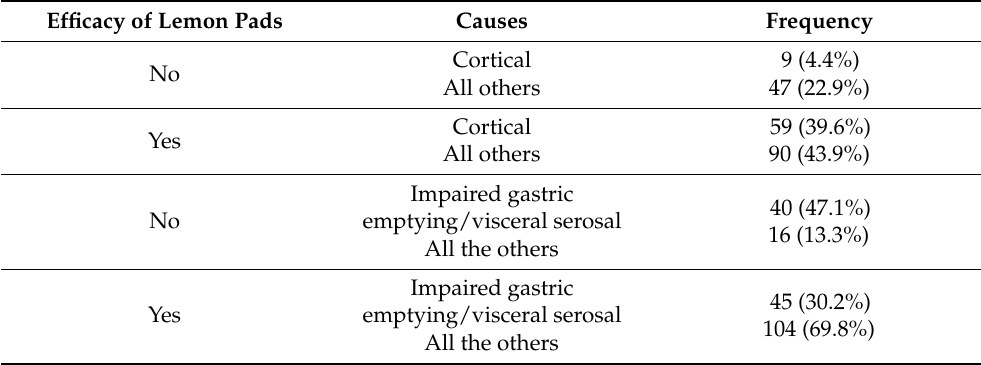
Table 2. Cross-tabulation: efficacy of lemon pad applications related to causes for nausea and vomiting ( n =